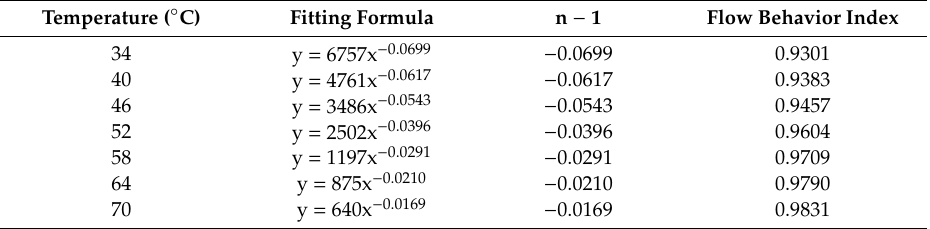
Figure 5. Flow behavior index of the basic bitumen. Table 5. Fitted results of flow behavior index at di ff erent